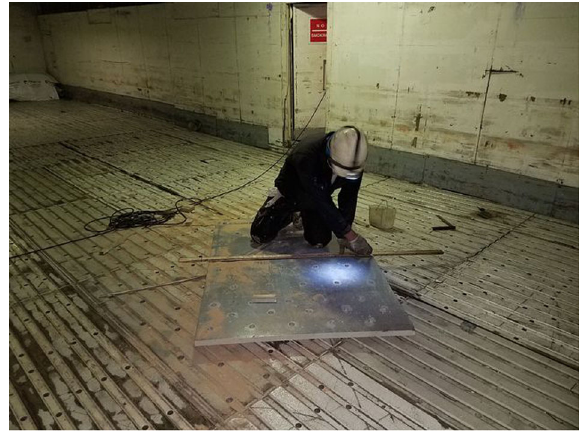
Fig. 8 Ship Repairs. A photograph was taken by a participant of a seafarer repairing the